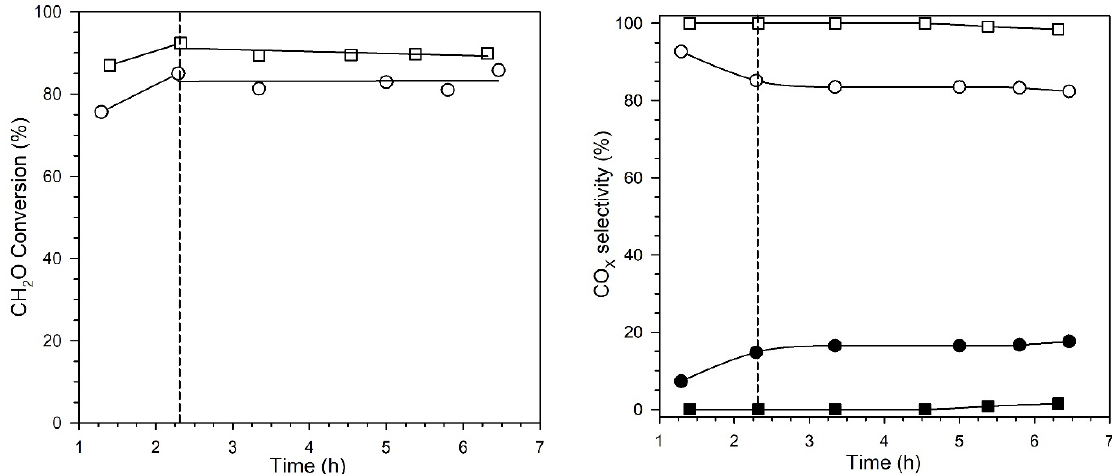
Figure 12. ( left ) CH 2 O conversion and ( right ) CO x selectivity, including (filled) CO selectivity and (unfilled) CO 2 selectivity for (circles) 2%Pt/m-ZrO 2 and (squares) 2.5%Na-2%Pt/m-ZrO 2 catalysts.